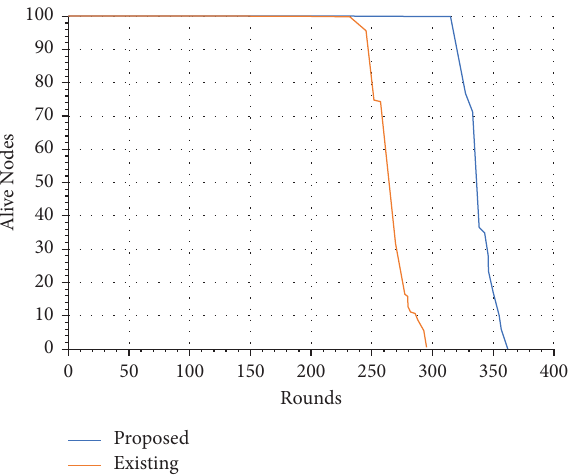
Figure 2: Comparative analysis of alive